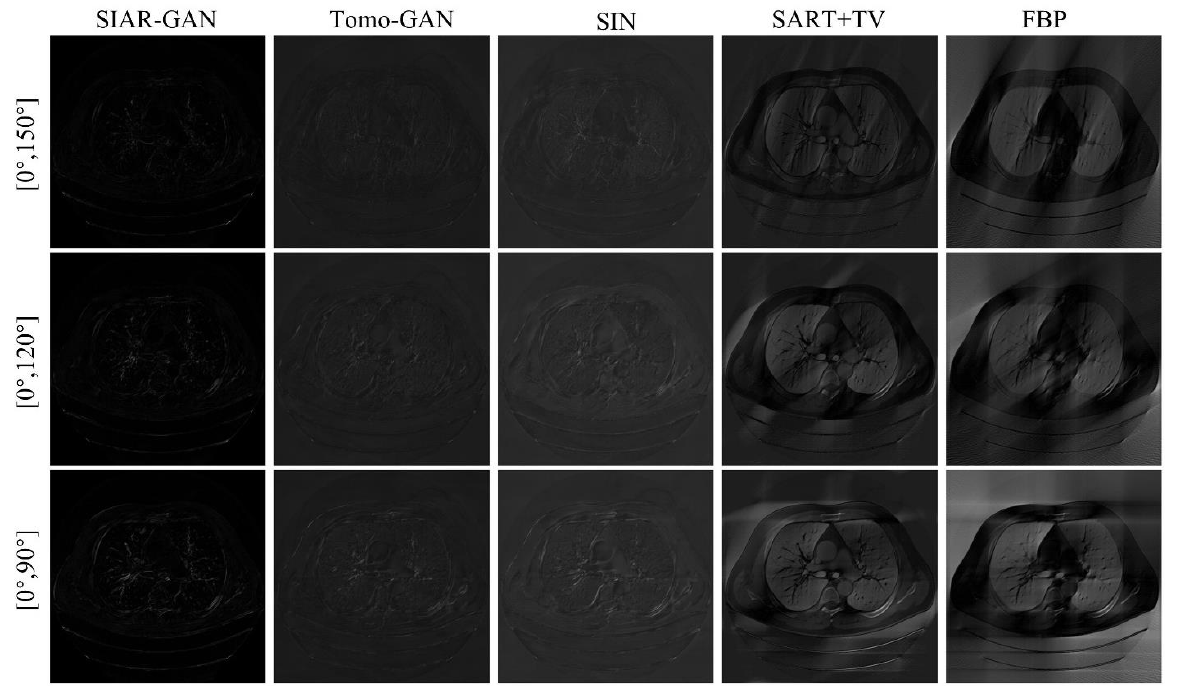
Figure 8. The absolute difference between the experimental results of each method and the reference results. The pixel range of the images is [0, 255]. (Best viewed with zoom-in).